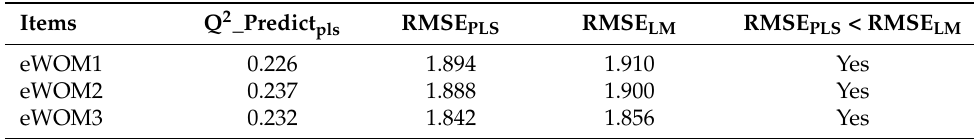
Table 5. Structural model predictive power assessment for eWOM as target